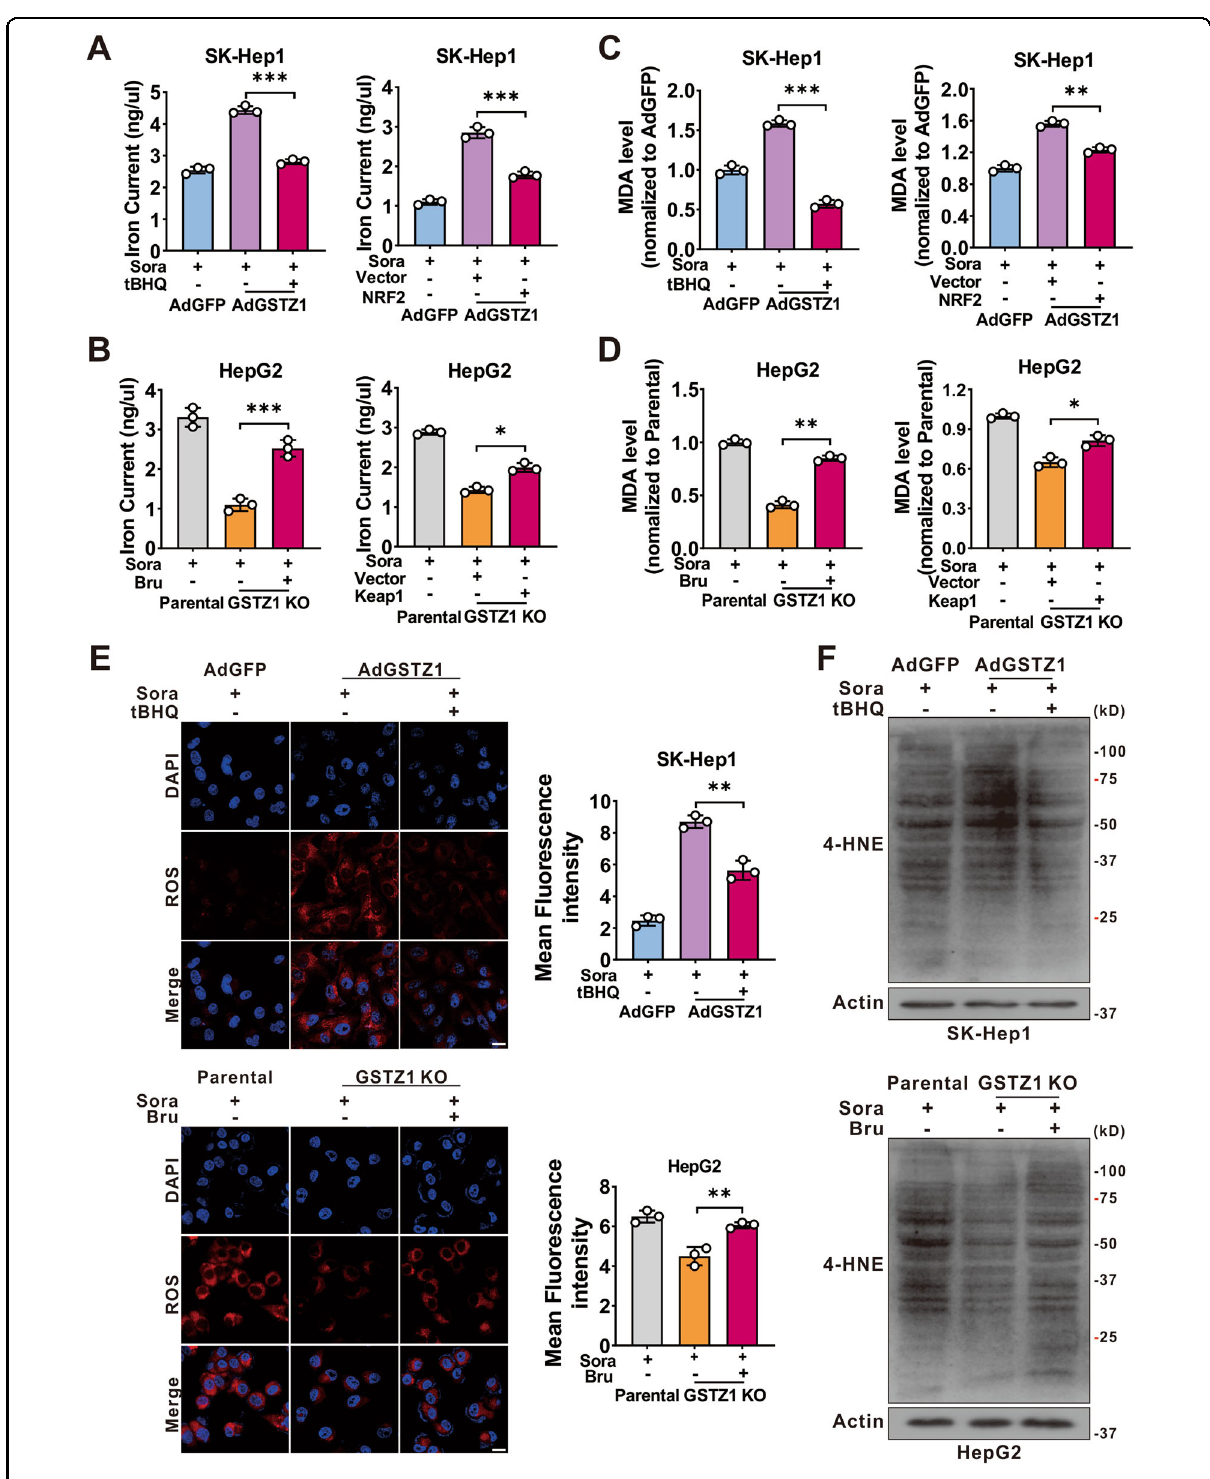
Fig. 5 (See legend on next